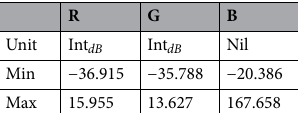
Table 9. Statistical summary of σ